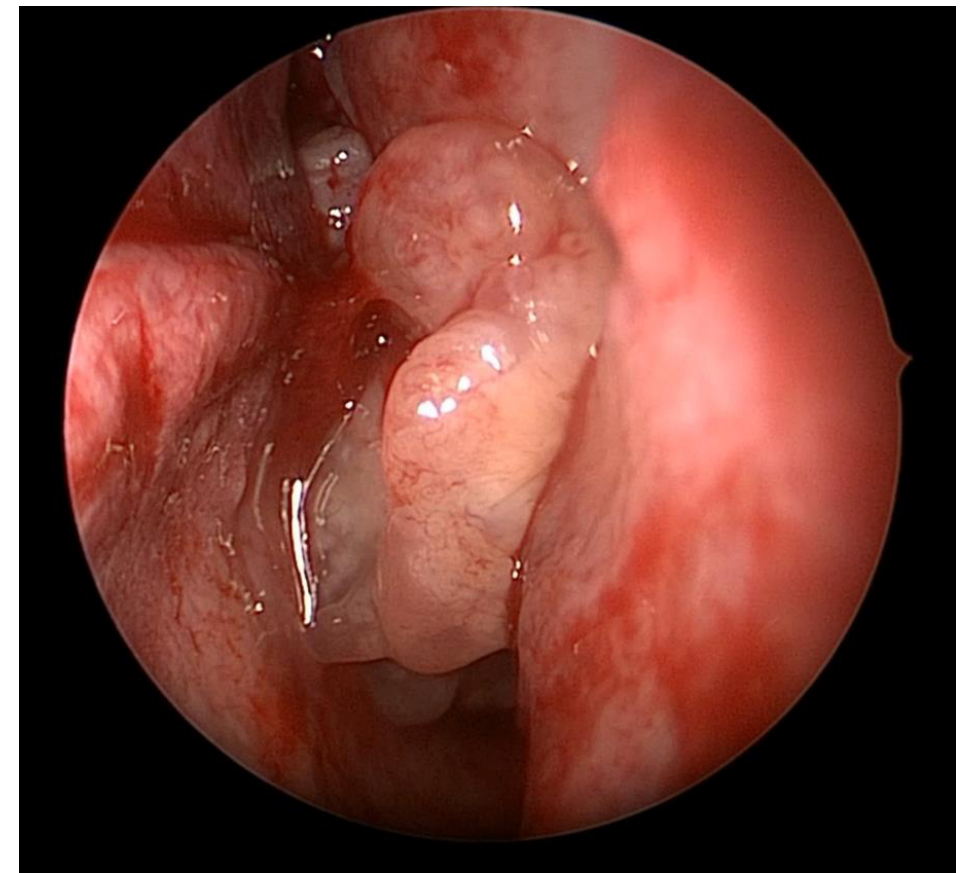
Figure 1. Biopsy-proven sinonasal inverted papilloma pedicled on the lateral nasal wall.